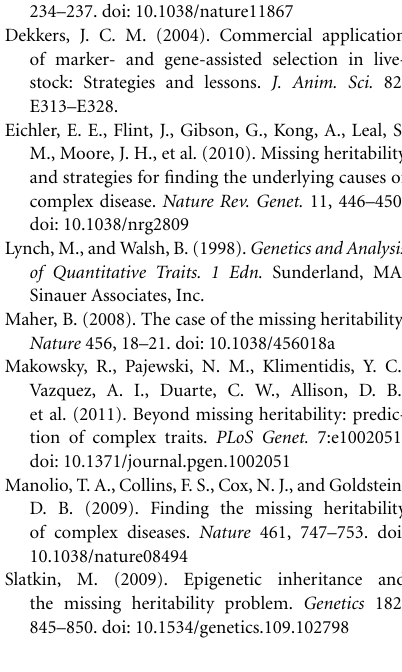
matrix (G) and those in the kinship matrix estimated by 32 randomly selected markers (R) in the yeast cross. Two markers were randomly selected from each of the 16 yeast chromosomes. G = ZZ T / n , R = XX T / m , where n is the number of markers across the genome (11,623), m is the number of randomly selected markers (32), Z is an N (number of individuals)-by- n matrix of genotype data and X is an N -by- m matrix for the selected markers. The straight line indicates equality and is shown as a visual